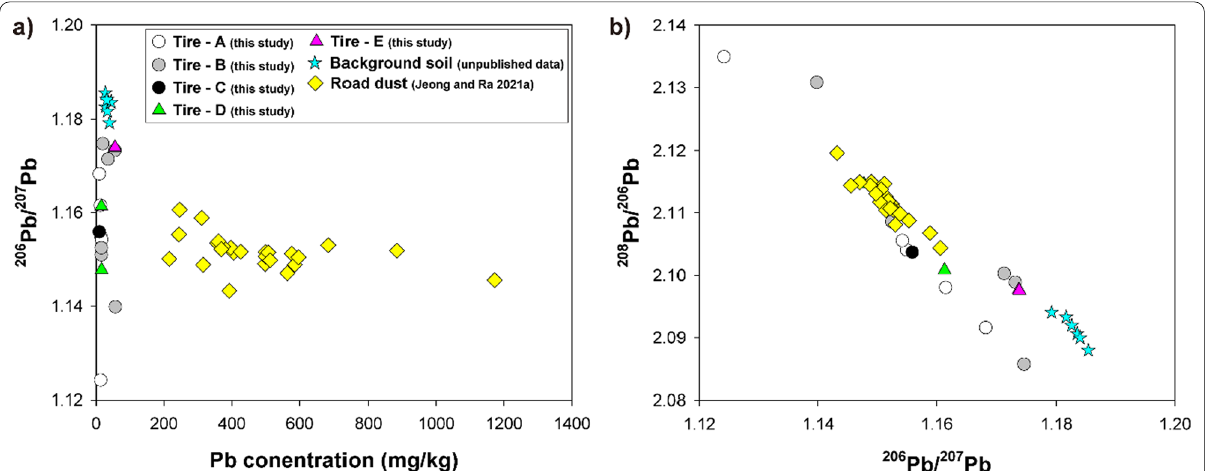
Fig. 3 Pb concentration (mg/kg) versus 206 Pb/ 207 Pb ratio ( a ) and 206 Pb/ 207 Pb ratio versus 208 Pb/ 206 Pb ratio ( b ) plots for the tire samples in this study, background soil, and road dust of